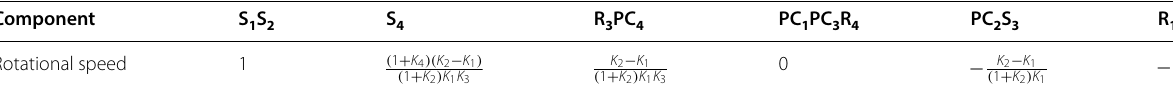
Table 2 Rotational speed of each component when C and F engaged (r/min) Component